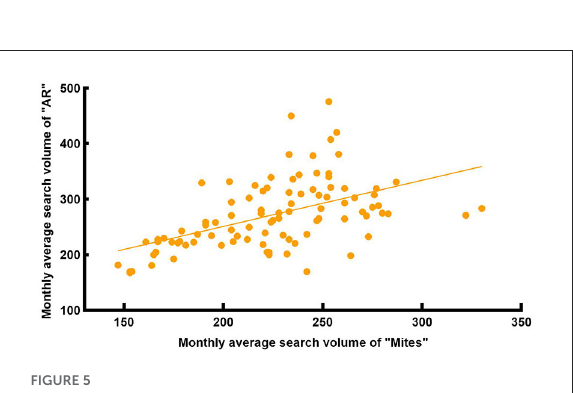
FIGURE5 Correlation between the search volume of “AR” and “Mites” in Wuhan from 2014 to 2021.